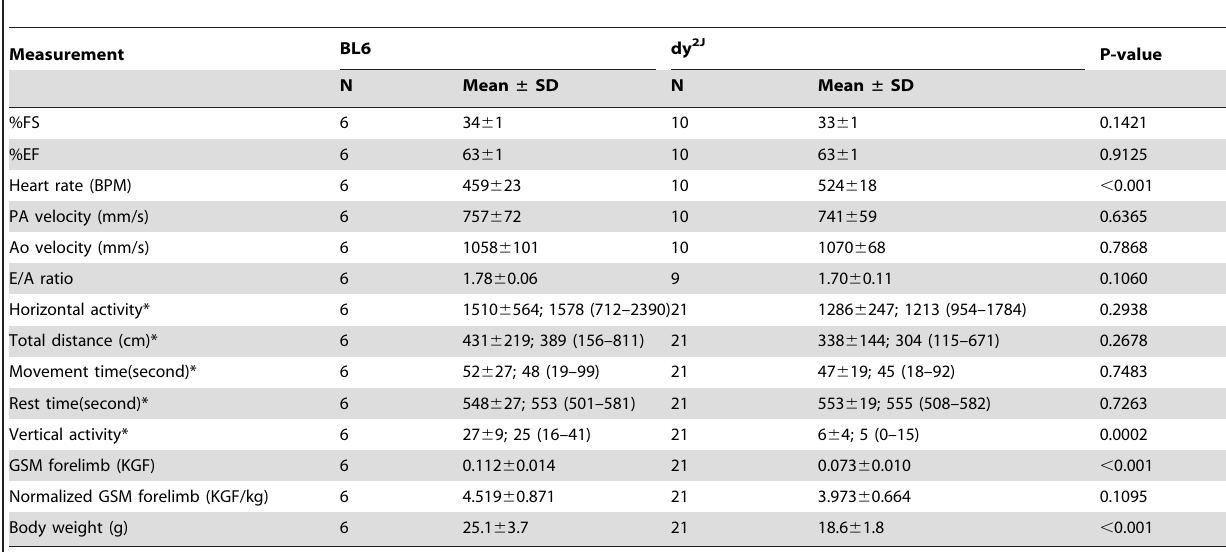
Table 1. Baseline outcome measures for BL6 control and dy 2J mice at 12–15 weeks of age show decreased body weights, forelimb grip strength, vertical activity and increased heart rates in dy 2J